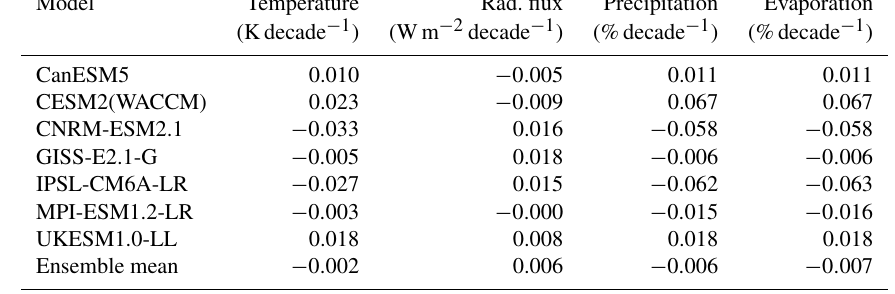
Table 2. Decadal trends in the global mean temperature, net TOA radiative flux, precipitation, and evaporation values shown in Fig. 1 for each model. Trends are calculated across the years 11–100 to eliminate any effects due to initial transient adjustment to the abrupt forcing.